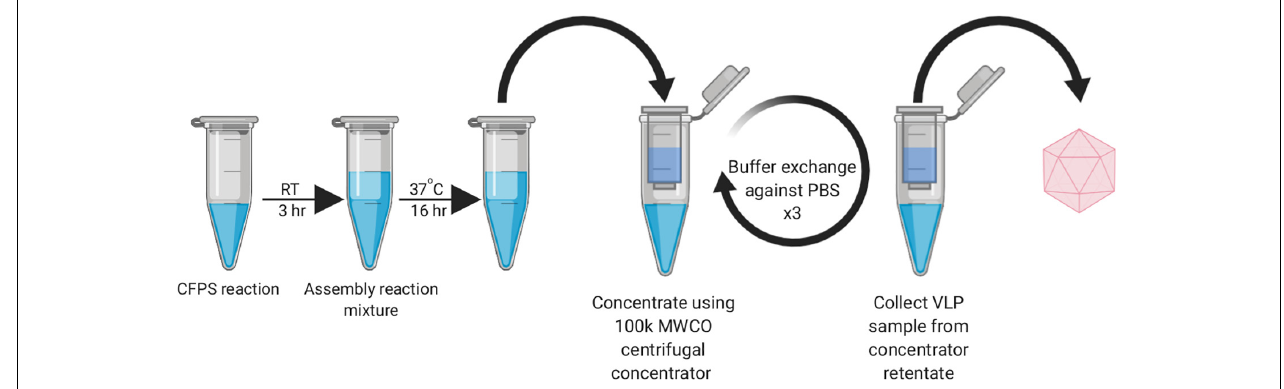
FIGURE 1 | Work-flow schematic of HBc VLP synthesis, assembly and centrifugal concentrator purification. Created with biorender.com.